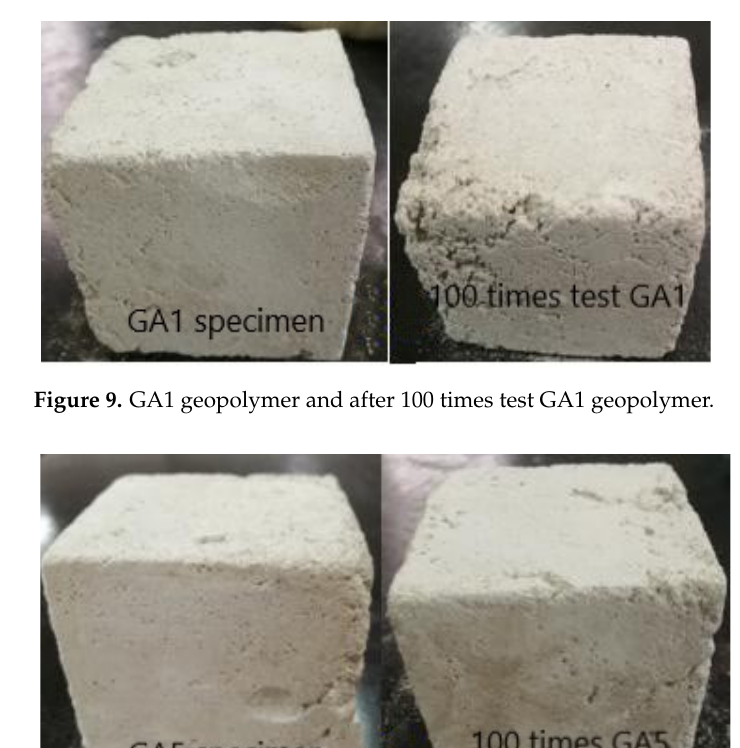
Figure 11. GS1 geopolymer and after 100 times test GS1 geopolymer. Figure 12. GS5 geopolymer and after 100 times test GS5 geopolymer.